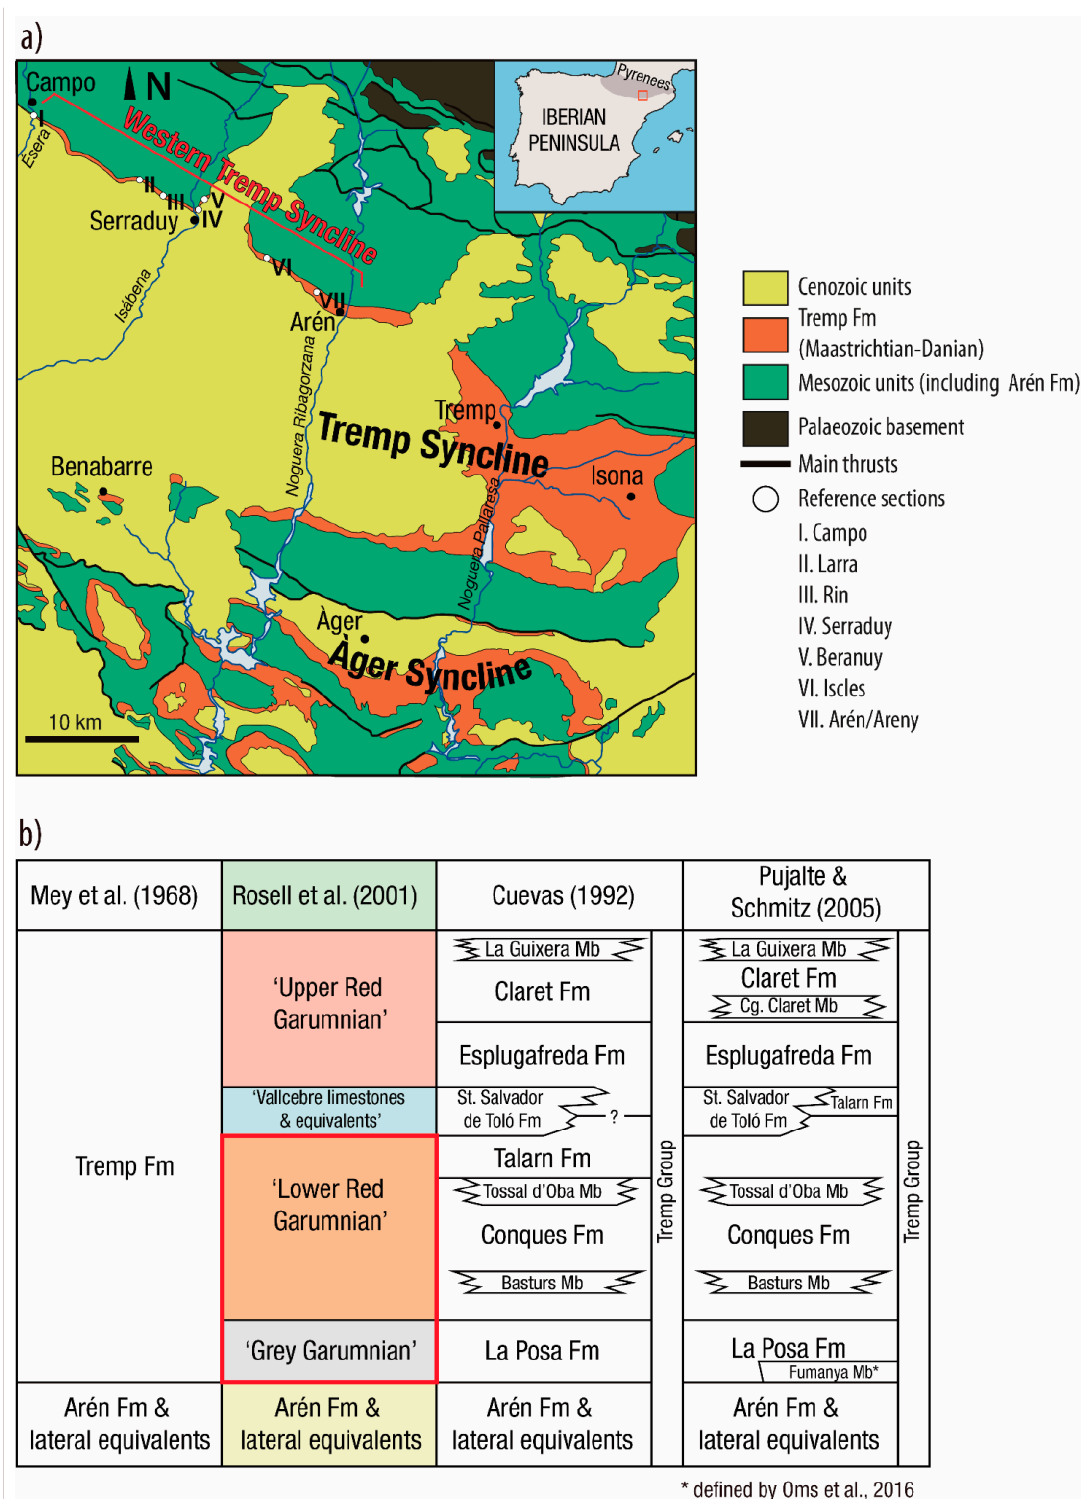
Figure 1. Geological and stratigraphic setting of the Tremp Syncline. ( a ) Geological map of the area of the South-Pyrenean Basin where the Tremp and À ger synclines are located. Reference sections of the Western Tremp Syncline are marked with Roman numerals: I Campo, II Larra, III Rin, IV Serraduy, V Beranuy, VI Iscl é s, VII Ar é n/Areny (map modified after [65]); ( b ) Stratigraphic proposals for the late Campanian-Paleocene deposits of the Tremp Syncline (modified after